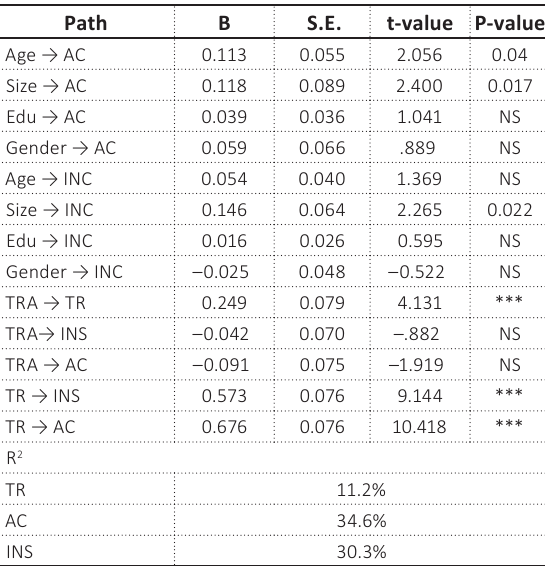
Figure 3. Indirect effects (Model Table 7. Structural model results of Model 2